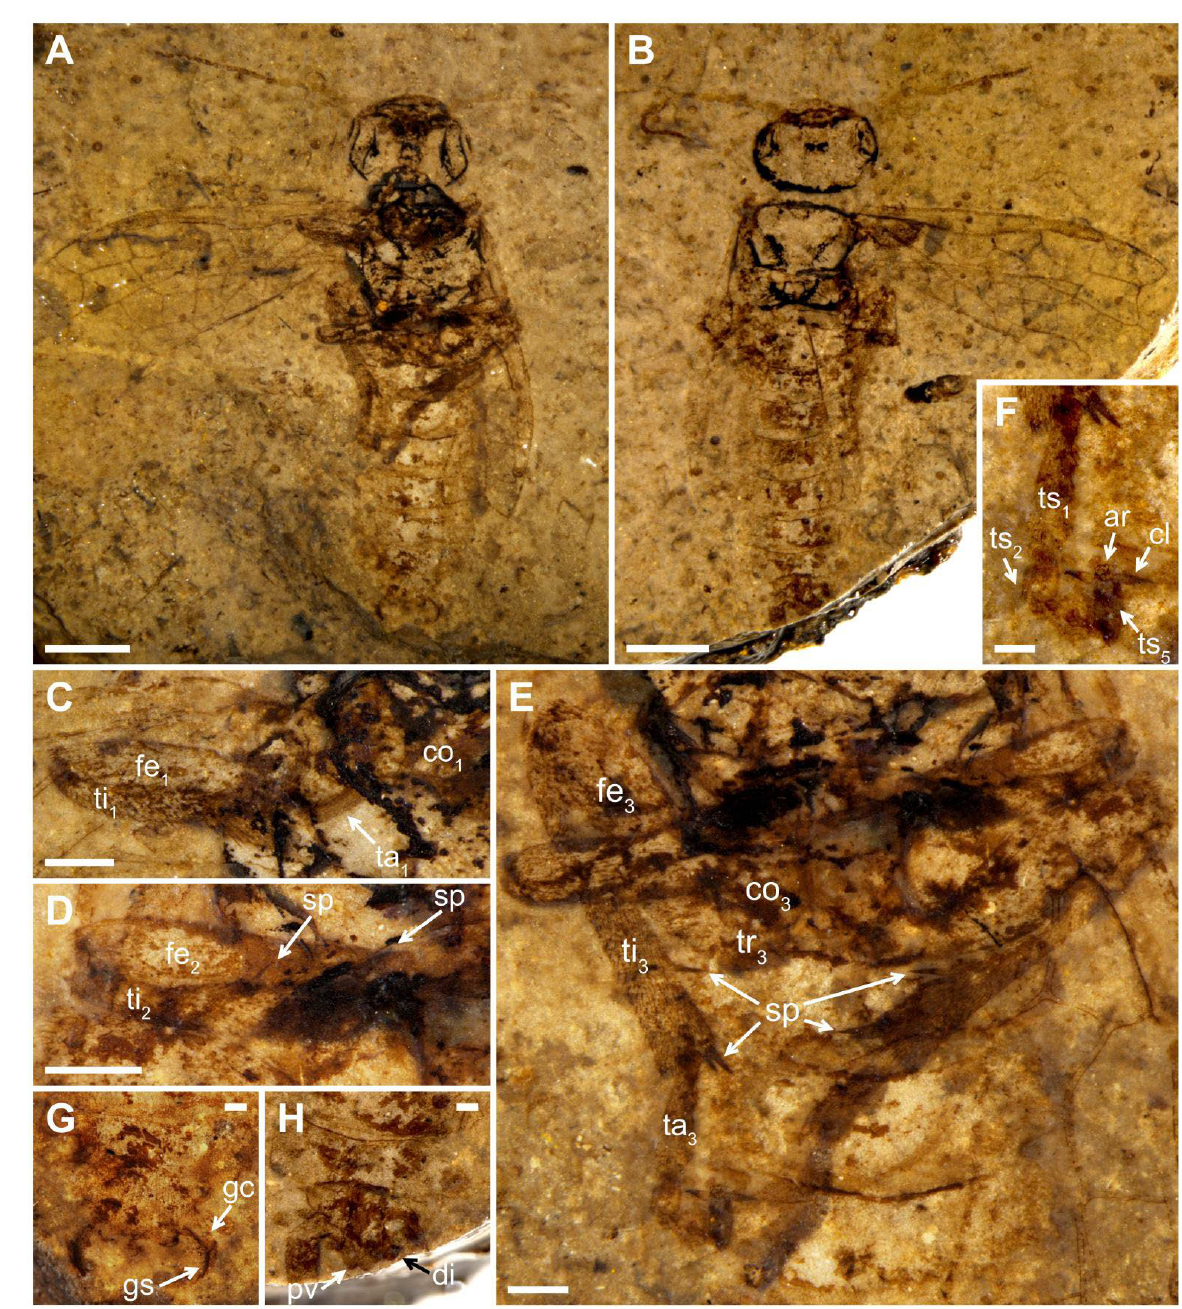
Figure 1. Scabolyda orientalis Wang, Rasnitsyn, Shih and Ren, 2014, New specimen (CNU-HYM- NN2022101p/c), male. All photos were taken wetted with 95% ethanol. ( A ) Ventral view of body as preserved. ( B ) Dorsal view of body as preserved. ( C ) Fore leg. ( D ) Mid leg. ( E ) Hind leg. ( F ) Hind tarsus. ( G ) Ventral view of genitalia as preserved. ( H ) Dorsal view of genitalia as preserved. Symbols: co 1 , co 3 = fore and hind coxa; tr 3 = hind trochanter; fe 1 , fe 2 , fe 3 = fore, mid and hind femur; ti 1 , ti 2 , ti 3 = fore, mid, and hind tibia; sp = spur; ta 1 , ta 3 = fore and hind tarsus; ts 1 –ts 5 = 1st–5th tarsal segments; cl = claw; ar = arcus; gc = gonocoxa; gs = gonostylus; pv = penial valve; di = digitus. Scale bars: 2 mm in ( A , B ); 0.25 mm in ( C – E ); 0.25 mm in ( F – H) .